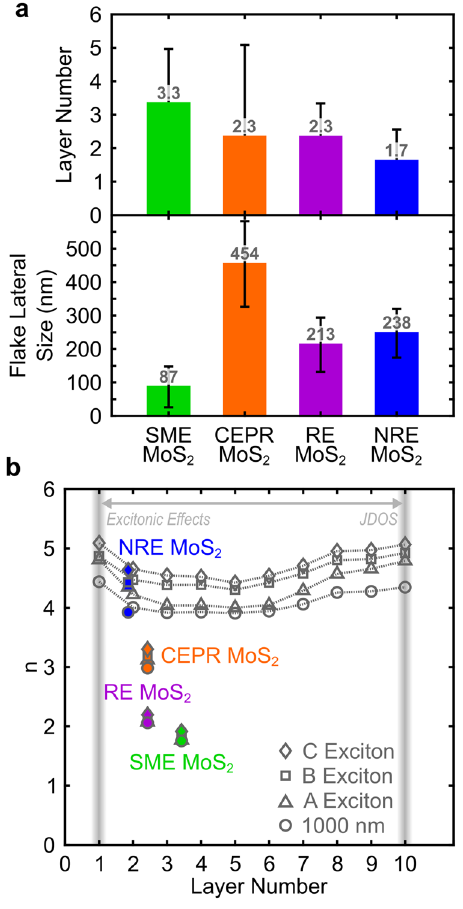
4 Exfoliation procedure-dependent MoS 2 dimension. a Comparison of average estimated exfoliated MoS 2 fl ake dimen- sions from AFM image analyses with positive standard deviations representing >100 fl akes from several images and image areas. Error bars for layer number in a correspond to 1.4, 2.5, 0.9, and 0.8 for SME, CEPR, RE, and NRE MoS 2 , respectively. Error bars for fl ake lateral size in a correspond to ±61, ±128, ±81, and ±75 for SME, CEPR, RE, and NRE MoS 2 , respectively. b Comparison of derived refractive indices, n , at peak A, B, and C exciton energies and at 1000 nm for each MoS 2 fi lm with respect to estimated exfoliated MoS 2 fl ake layer thicknesses. The layer-dependent n values reported here are compared to those reported by Yu et al. involving dominating excitonic effects (i.e., layer thickness-dependent quantum con fi ne- ment interplay) and increase in joint density of states (JDOS) with number of layers 6 . Bulk-like properties are generally considered to occur at ≥ 10